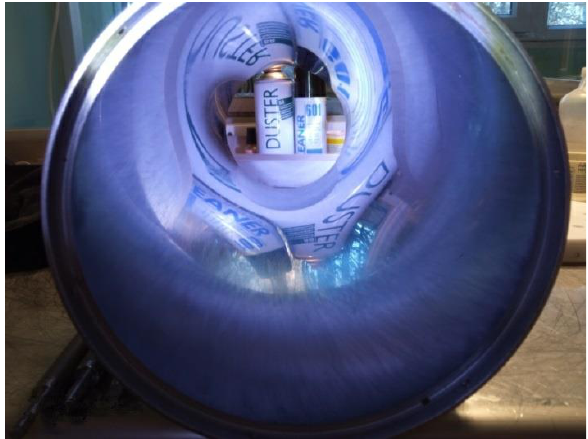
Figure 4. The internal surface of the cathode of multicathode counter.